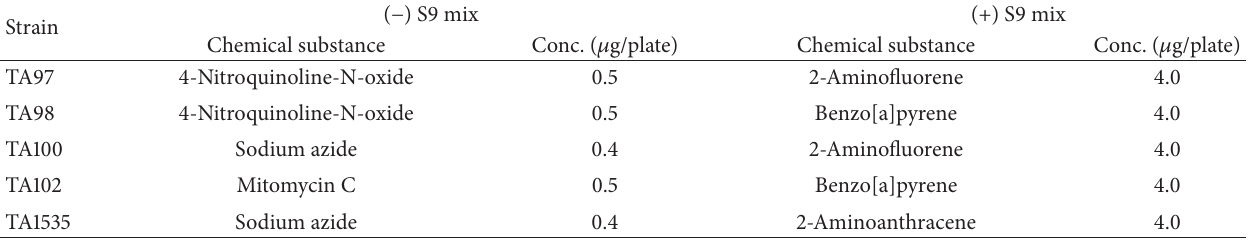
Table 1: Chemical substances and concentrations used as positive controls for reverse mutation assay.